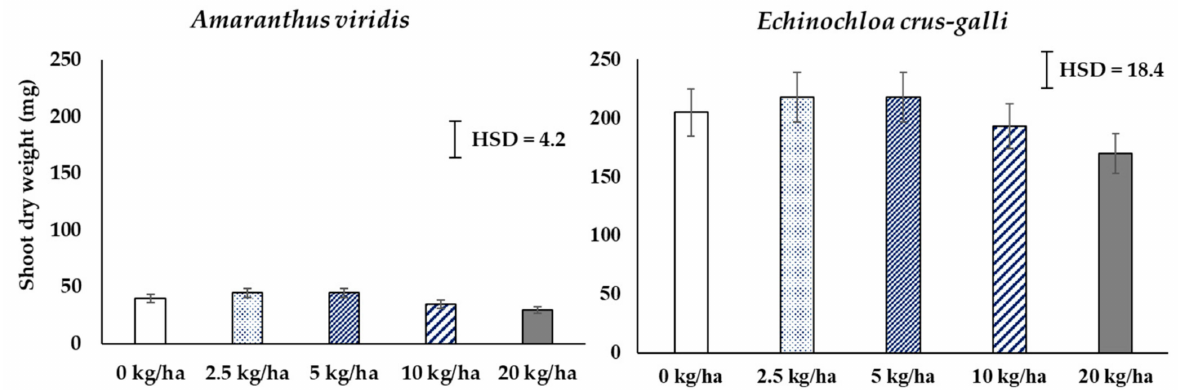
Figure 2. Emergence (%) of E. crus-galli and A. viridis after pre-emergence spray application of CH product at different days after treatment under pot experiment in glasshouse conditions. Means expressed error bar ( ± SE) with four replicates. Tukey’s HSD range test at p < 0.05 identified any difference between means of treatments.